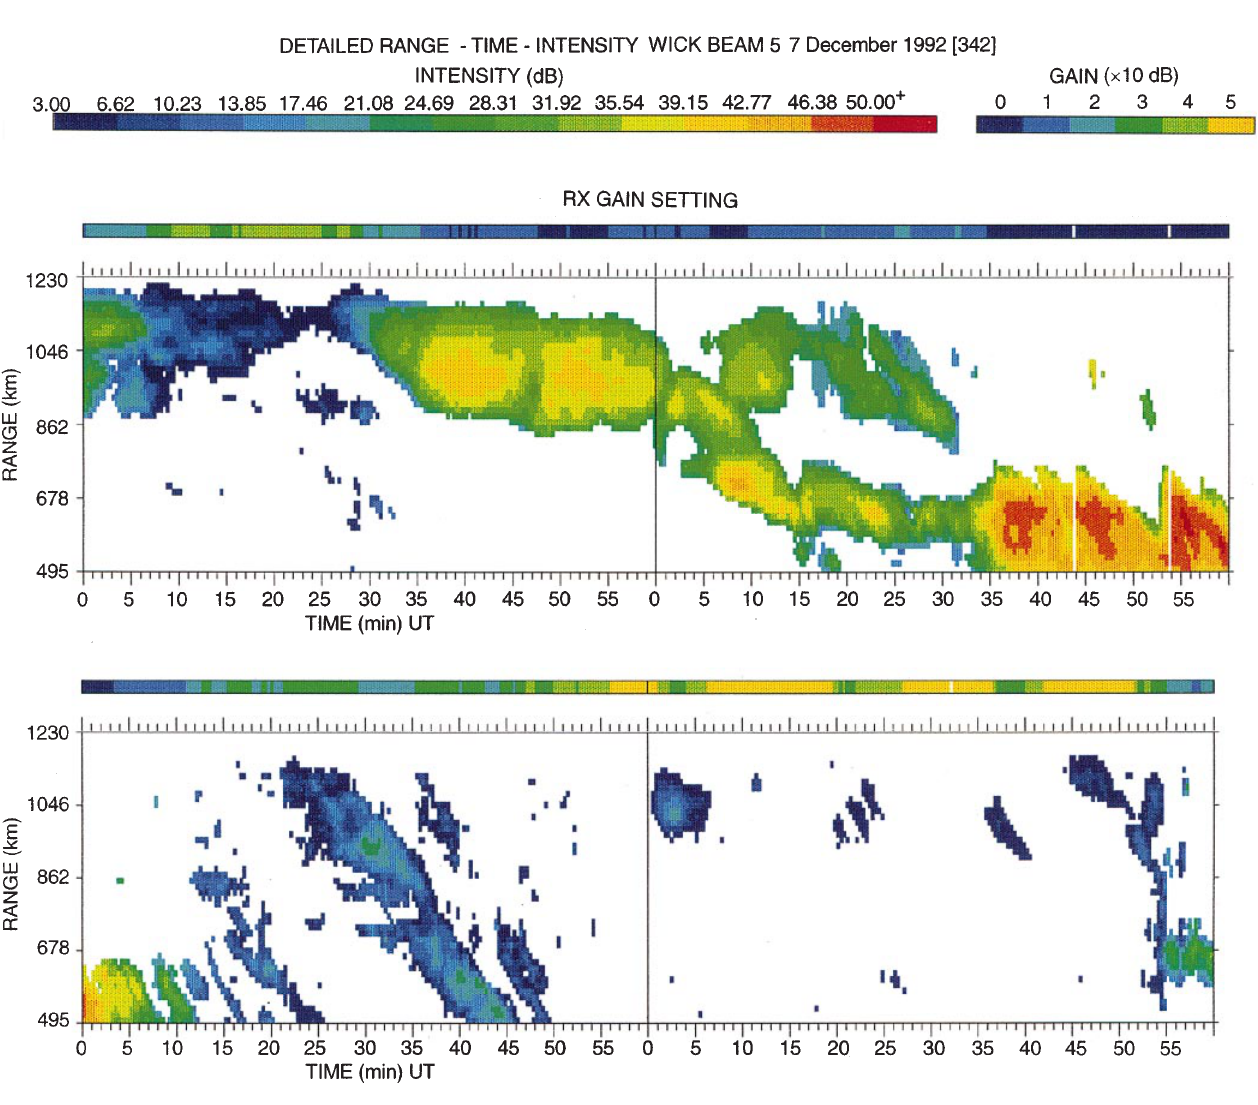
used here. It is a summary plot used to indicate the existence of backscatter. The colour scale represents the intensity of the